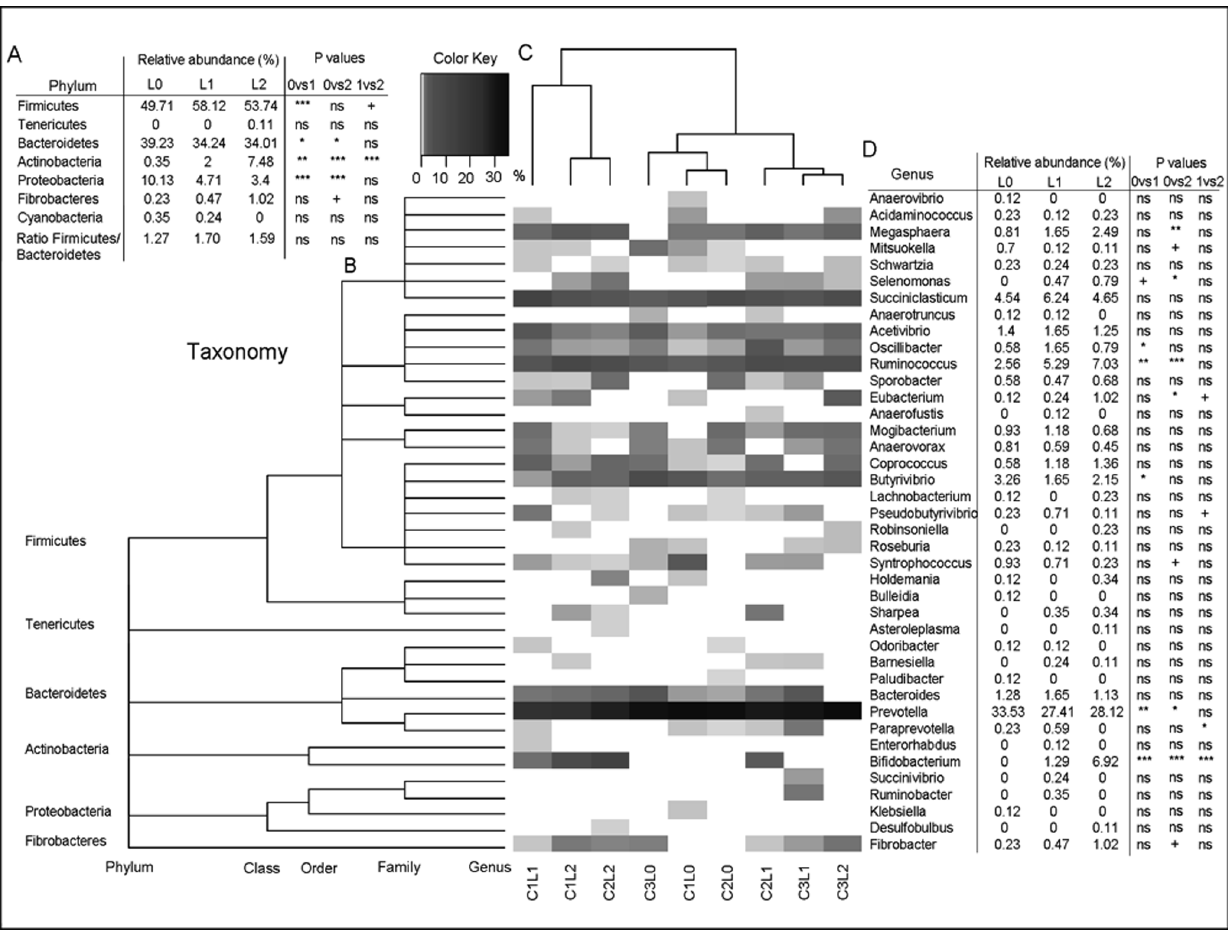
Figure 3. Heatmap of the distribution of the relative abundance of the genera detected with the SARST method. A: Relative abundance of the phyla detected and statistical analysis for treatments. B: Taxonomic classification of the genera. C: Morista-Horn cluster of the relative abundance of the genera. D: Genera detected and statistical analysis for treatments means (Metastats for the sequence count data and Anova for the ratio Firmicutes/Bacteroidetes). L0=Control; L1=0.5 g/d of yeast; L2=5 g/d of yeast; 0vs1=Control vs 0.5 g/d of yeast; 0vs2=Control vs 5 g/ d of yeast; 1vs2=0.5 g/d of yeast vs 5 g/d of yeast. P value: ns= . 0.1, + = , 0.1; *= , 0.05; **= , 0.01; ***= , 0.001.